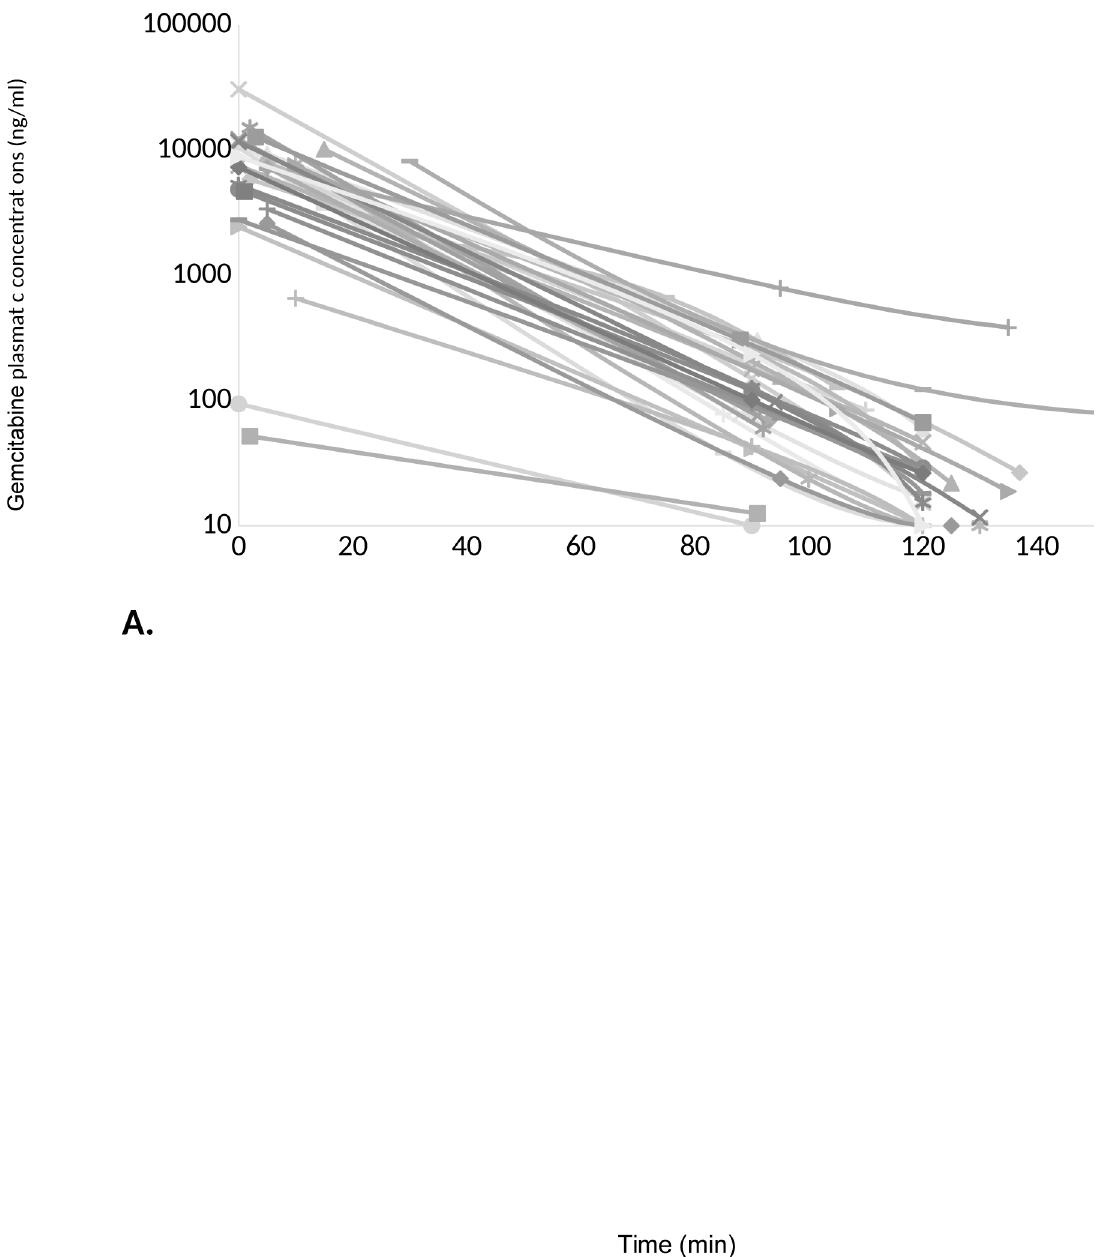
Fig 2. Pharmacokinetics profiles of gemcitabine (A) and its metabolite (B) overtime during the first round of gemcitabine administration in pancreatic adenocarcinoma cancer patients. Patients have been sampled before infusion, at the end, and 90 and 120 minutes after ending the infusion. A wide inter-individual variability is observed, either for gemcitabine or for